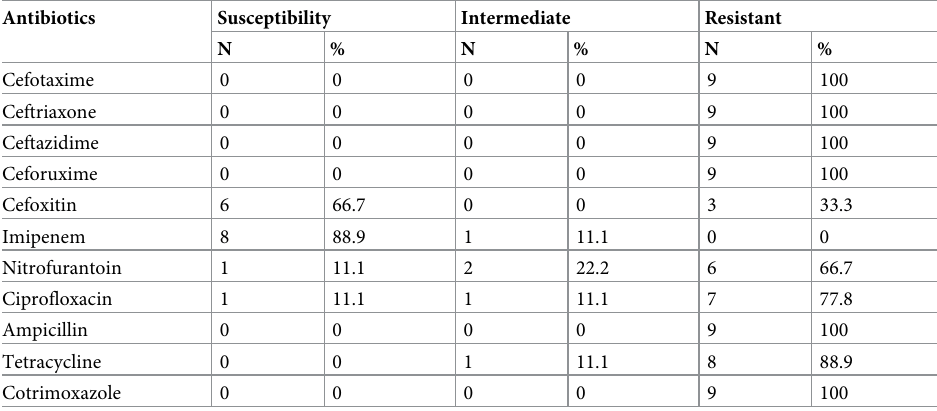
Table 5. Antibiotic resistant pattern of Klebsiellapneumonia producing ESBLs among food handlers. Antibiotics